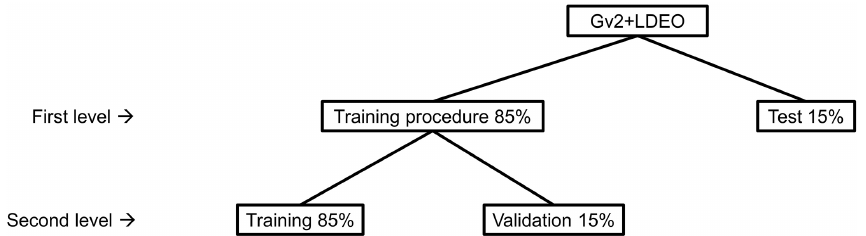
Figure 1. Division of the complete database in the datasets needed to train the neural network. The percentages in each level are relative to the number of data in the previous one. Data in the datasets of the first level are always the same for each network. Data in the sets of the second level are randomly associated with each set for each network to find the best network weights because of the different starting points in the error weight space of the training process (see also Broullón et al.,